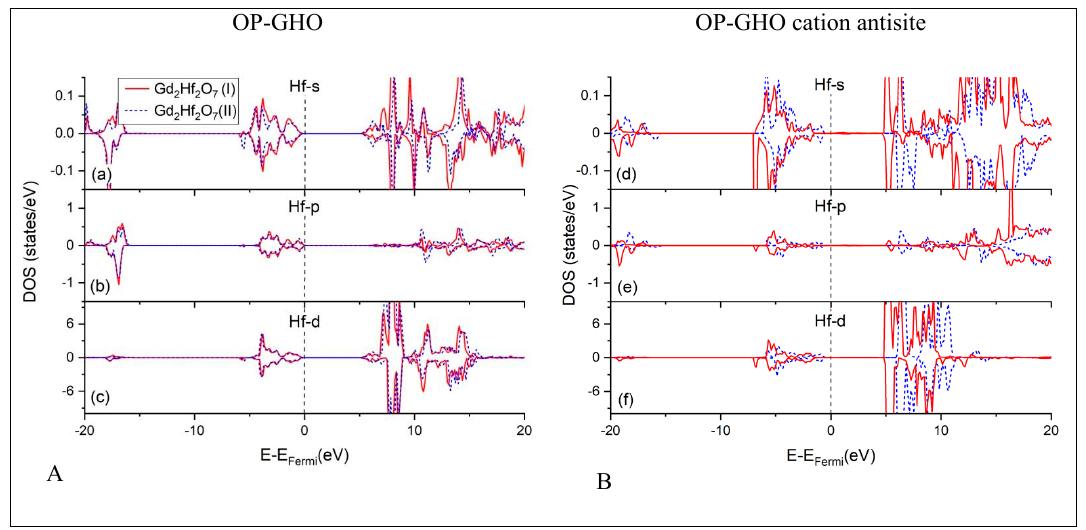
Figure 5. Hf DOS spectra per s, p, and d atomic orbitals for the OP-GHO structures, with the Ο 8a sites simulated via ghost atoms (I) and being vacant (II). ( A ). ( a ) – ( c ) stable structures and ( B ). ( d ) – ( f ) cation antisites. Molecules 2020 , 25 , x